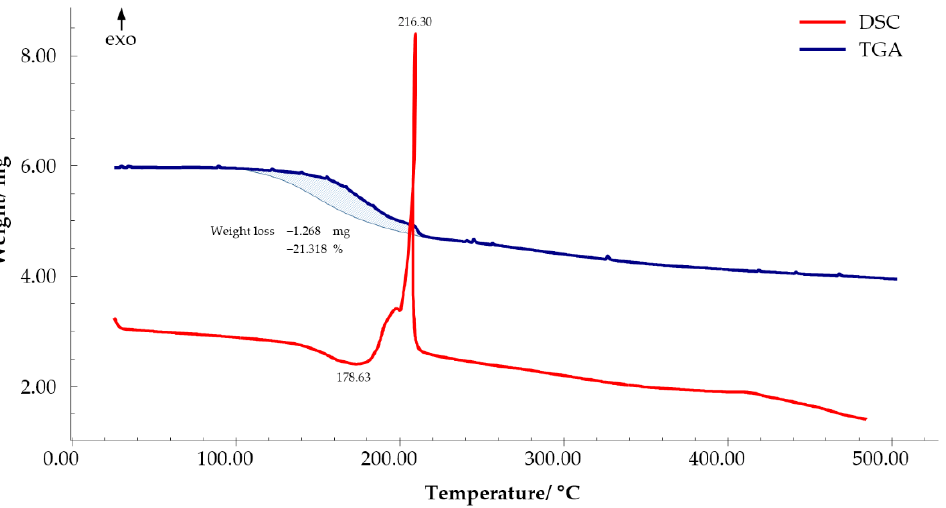
Figure 7. Thermal analyses (thermogravimetry with insert of differential scanning calorimetry) of [Cd(pfb) 2 (phen)] n ( 1 ). Blue—TGA curve, Red—DSC curve.